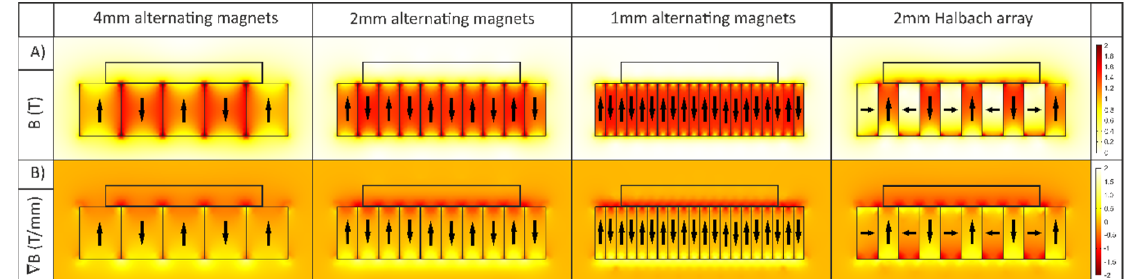
Figure 4. COMSOL simulation of ( A ) the magnetic field and, ( B ) the field gradient, resulting from magnets in an alternating orientation and Halbach array.